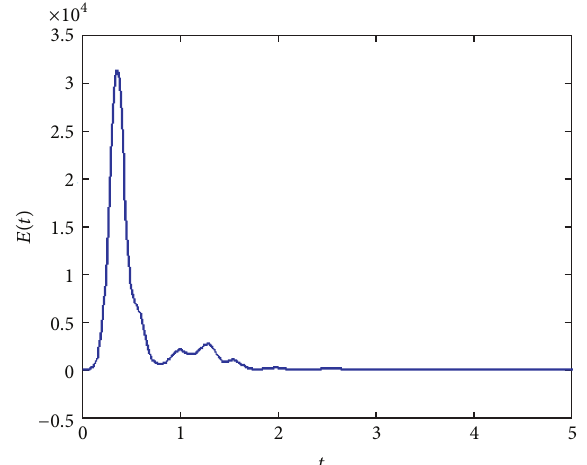
Figure 2: The outer synchronization error 𝐸(𝑡) between driving network (9) and response network (10).